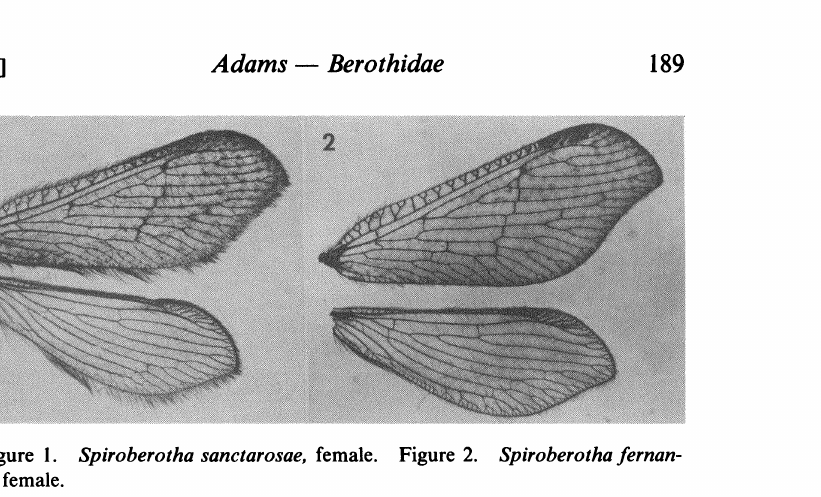
Figure 1. Spiroberotha sanctarosae, female. Figure 2. Spiroberotha fernan- dezi, female. anteriorly fuscous and densely fuscous-setose; flagellum pale yellow. Pronotum pale yellow with a few fuscous spots, markings narrowly fuscous. Mesonotum similarly marked, but with fuscous areas at base of scutellum and irregularly elsewhere. Thoracic pleura fus- cous, pale marked. Setae of dorsum of scapes, vertex, and pale central thoracic area pale yellow, of dark lateral stripe area, fuscous, of pleurae mostly white. Legs pale, femora lightly spotted, tibiae dark punctate with row of larger dark spots on exterior surface, tarsomeres fuscous-tipped; setae mostly pale, some on tibia and tarsus dark. In females, a dense array of black scales on fore coxa; patches anteriorly on mesopleuron, metapleuron, and sometimes mesocoxa with both black and white scales. Wings (Fig. 1): Forewing only weakly falcate, margin posterior to apex almost straight. Membrane pale to light brown, dark spots at base of RSd-MA, crossvein r-rs, and wing tip; gradates dark, barely dark margined; stigma fuscous or pale rufous; most veins pale with dark punctations. Hindwing setae, membrane and veins pale, with some punctations on costa of darkly marked individuals. Three gradates in